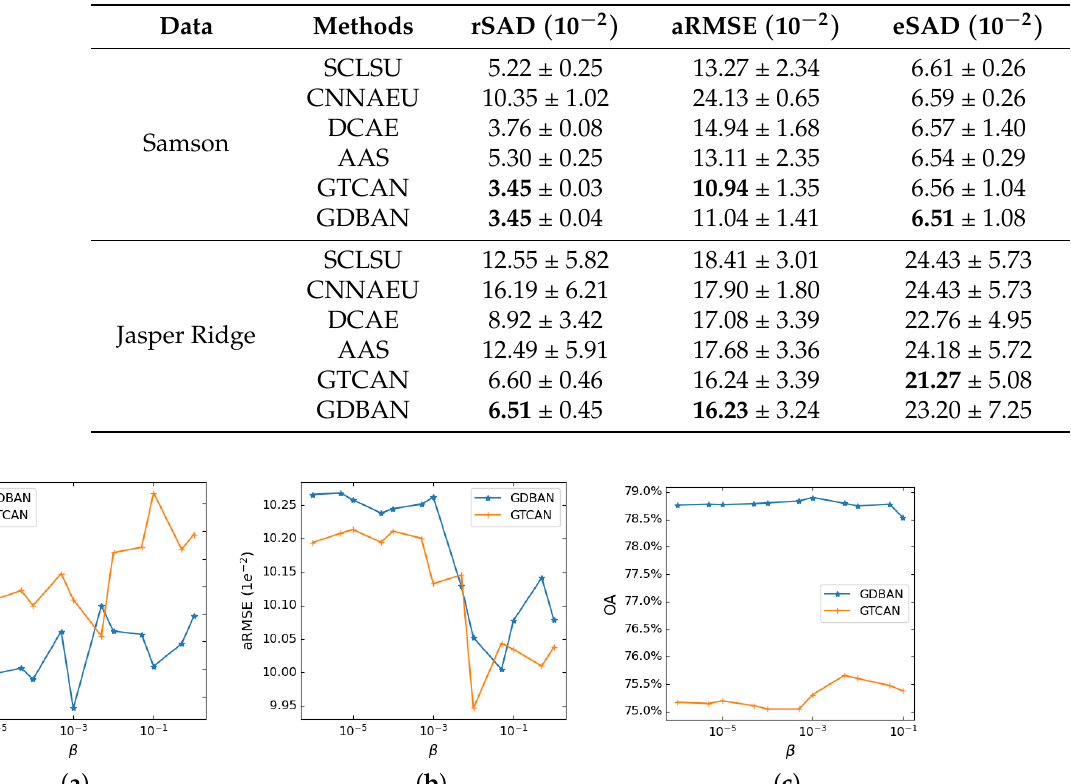
Table 4. Quantitative results on Samson and Jasper Ridge data. The optimal results are bolded.